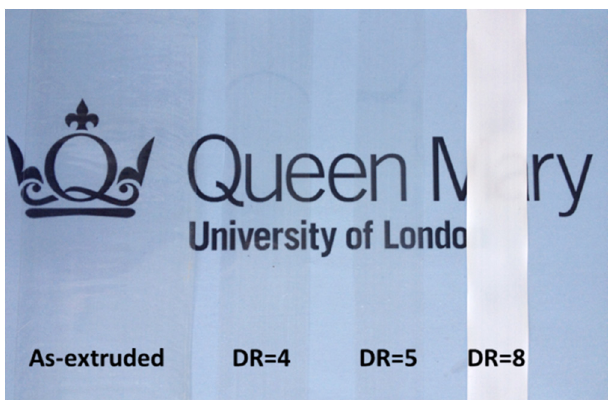
Figure 8. Optical appearance of PLLA tapes. From left to right; as-extruded tape, and tapes drawn at 90 °C to DR = 4, 5 and 8. There is a clear transition from fully transparent to an opaque tape structure at DR > 5.